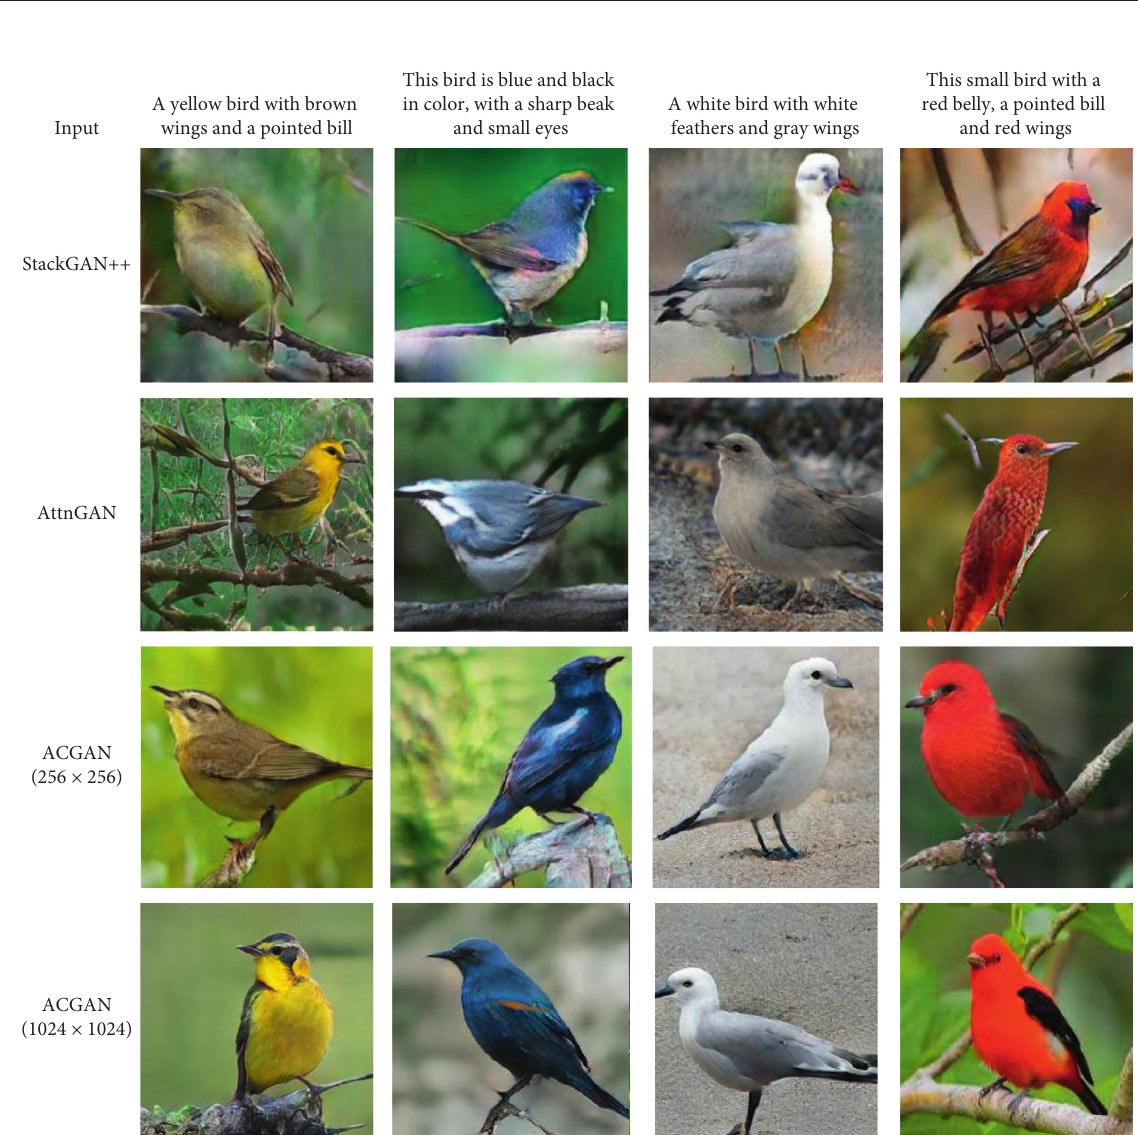
Figure 3: Images generated from descriptions using three GAN models trained on CUB test